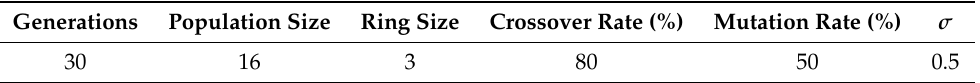
Table 2. Genetic algorithm